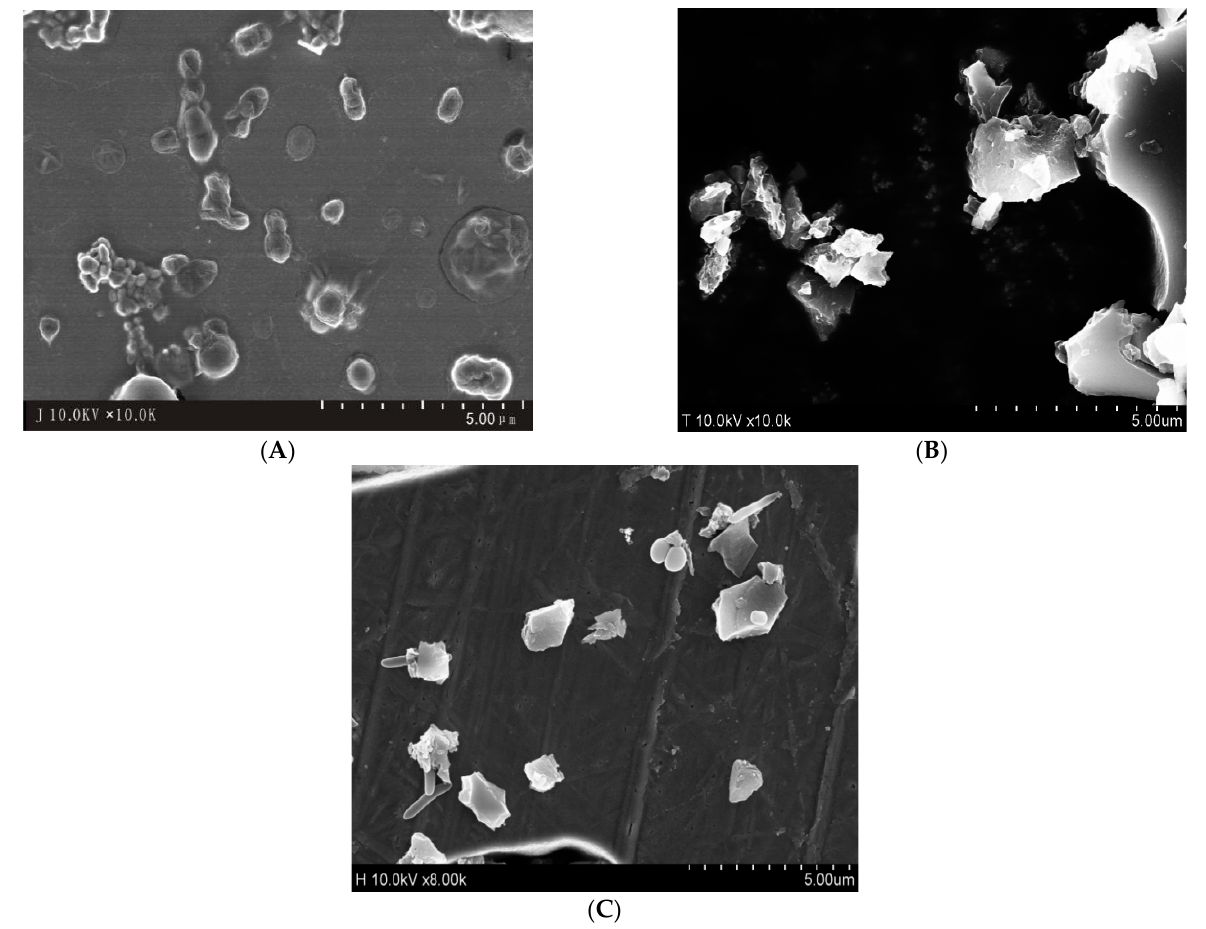
Figure 2. Scanning electronic microscope images: ( A ) degrading bacteria; ( B ) MAC; ( C ) bio-MAC.